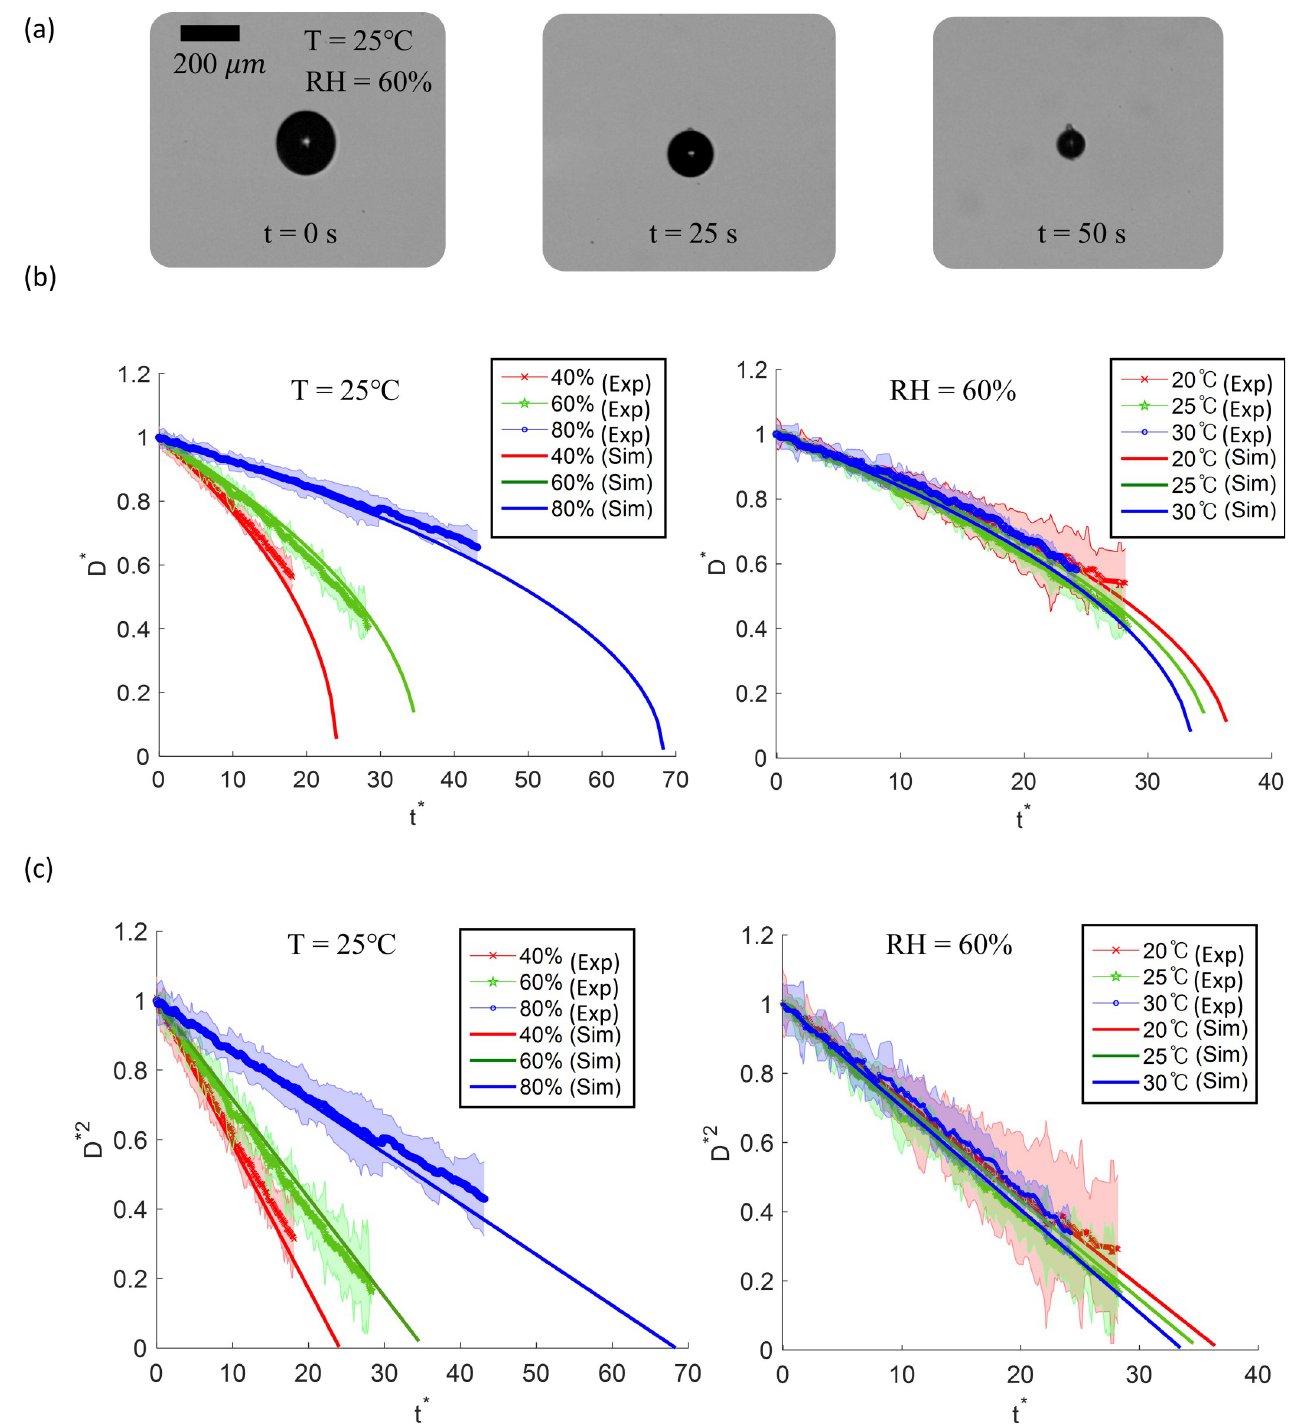
Fig 2. Experimental and modelling results of evaporating droplet. (a) Microdroplet evaporating at 25˚C and 60% relative humidity, (b) comparisons of diameter of droplet evaporation model and experiment, (c) comparisons of diameters squared of droplet evaporation model and experiment.